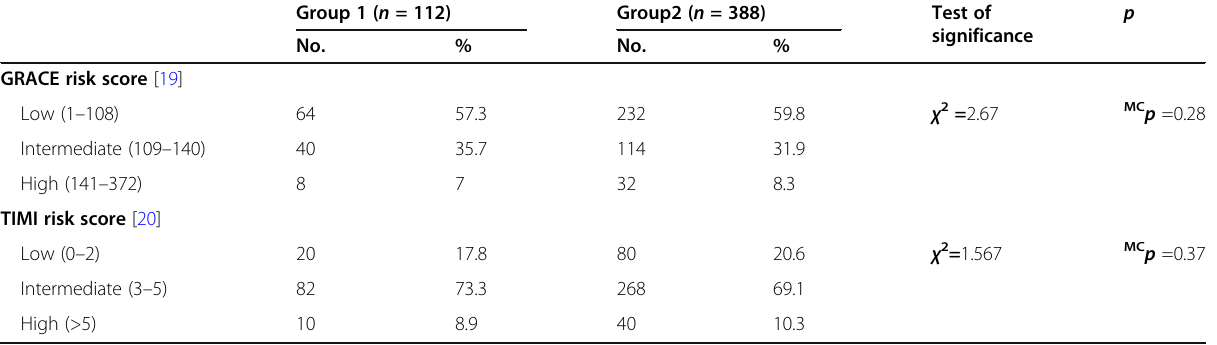
Table 3 GRACE risk score and TIMI risk score at admission of the studied population